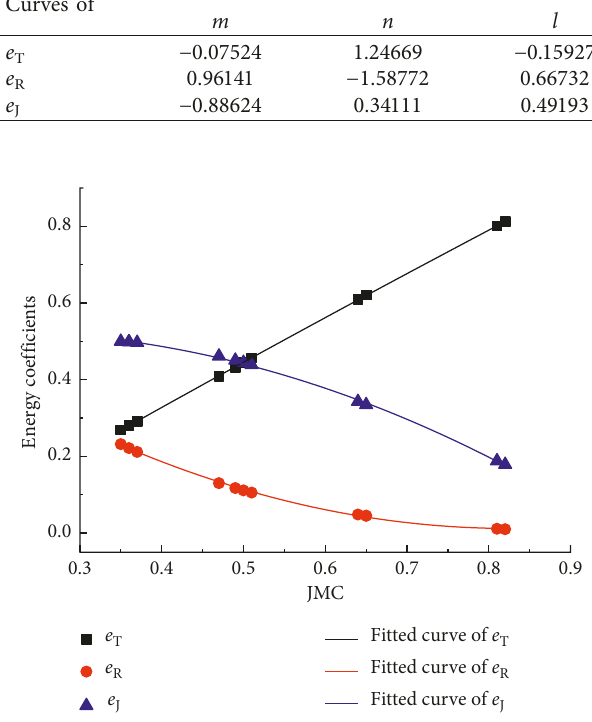
Figure 3: Relations of JMCs with e